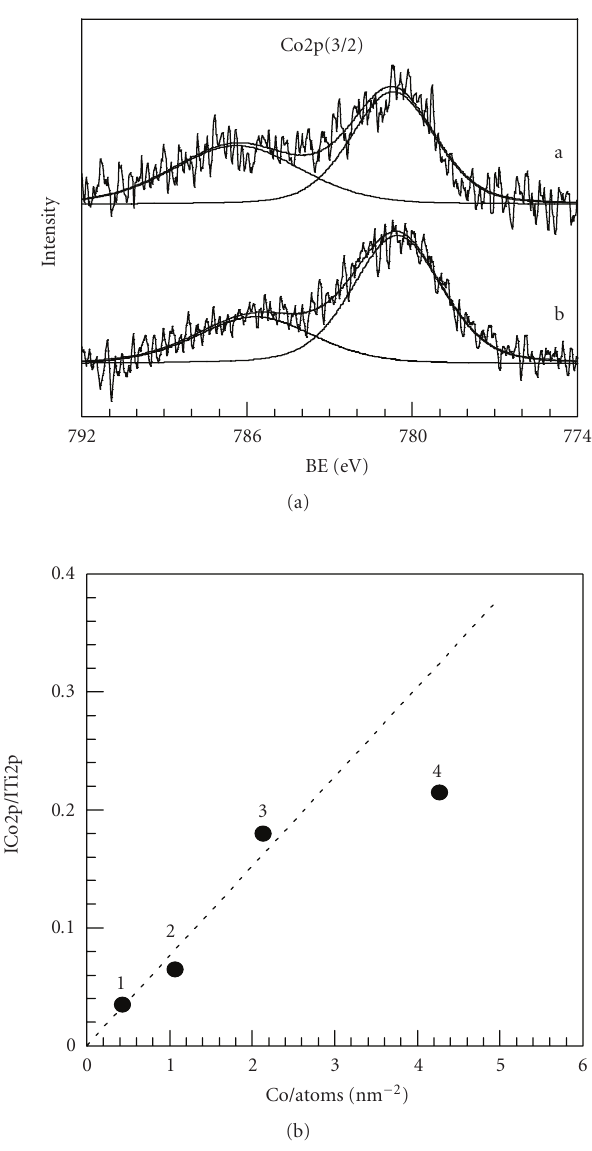
Figure 1: (a) XPS spectra in the Co2p(3/2) binding energy region for Co(1%)-TiO 2 (curve a) and Co(2%)-TiO 2 (curve b); (b) ratio of XPS peaks intensity, I(Co2p)/I(Ti2p), as a function of the surface concentration of cobalt for Co( x %)-TiO 2 with (1) x = 0 . 2%; (2) x = 0 . 5%; (3) x = 1%; (4) x = 2%. Full circles are the experimental data and the dashed line refers to calculated values (see text). The final calcination temperature for all samples was 400 ◦